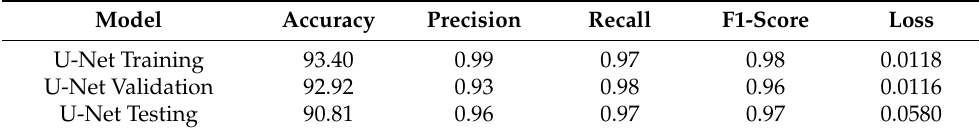
Table 3. U-Net best performing training, validation, and testing results. Model